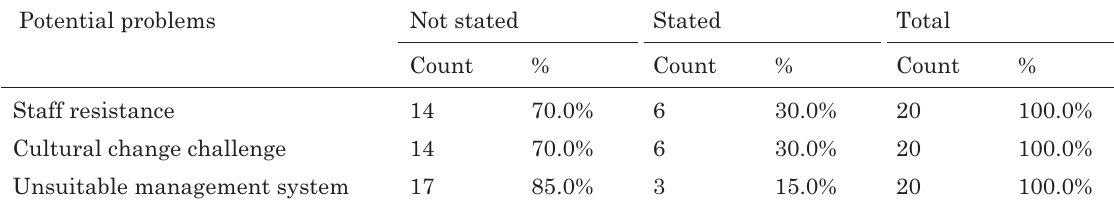
Table 1. Stated potential problems from ‘Non-territorial working environment’